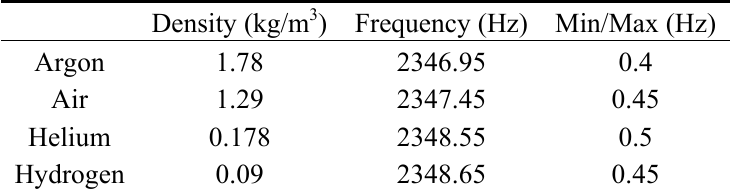
Table 1. Measured resonance frequency for different gases. Frequency is the averaged measured resonance frequency and min/max is the minimal and maximal deviation measured in